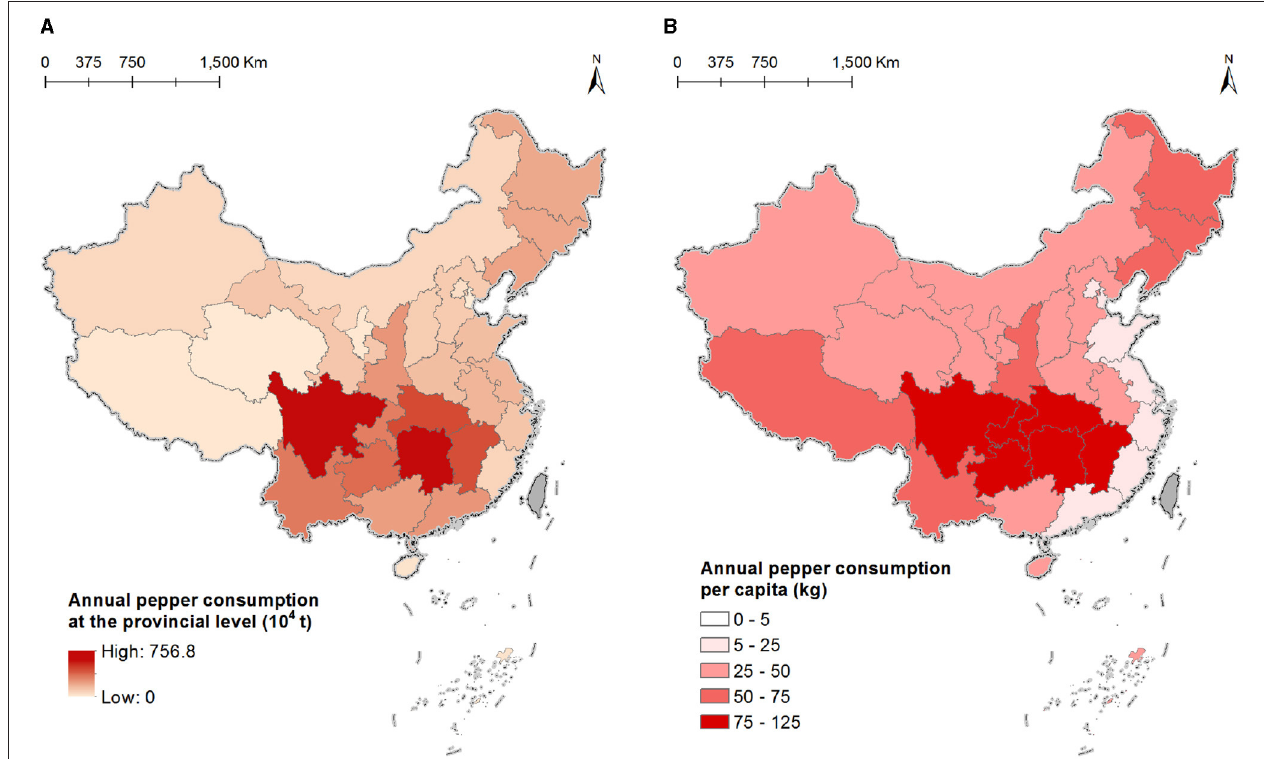
FIGURE 4 | Annual provincial-level pepper consumption rates. Data from China’s Taiwan, Hong Kong, and Macau are not available. (A) Total pepper consumption in each province. (B) Per capita pepper